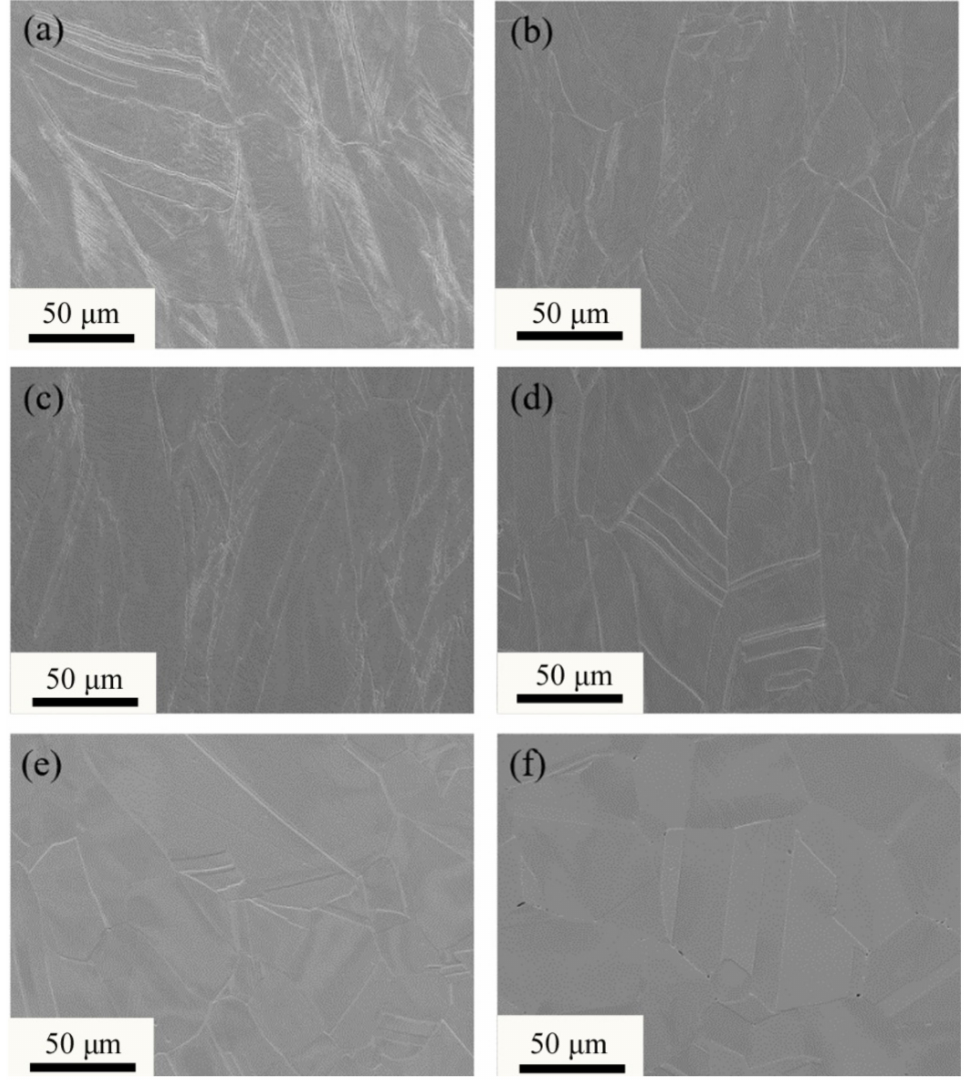
Figure 2. SEM micrographs of samples obtained by stretching at different temperatures: ( a ) room temperature, ( b ) 100 ◦ C, ( c ) 200 ◦ C, ( d ) 400 ◦ C, ( e ) 600 ◦ C, and ( f ) 800 ◦